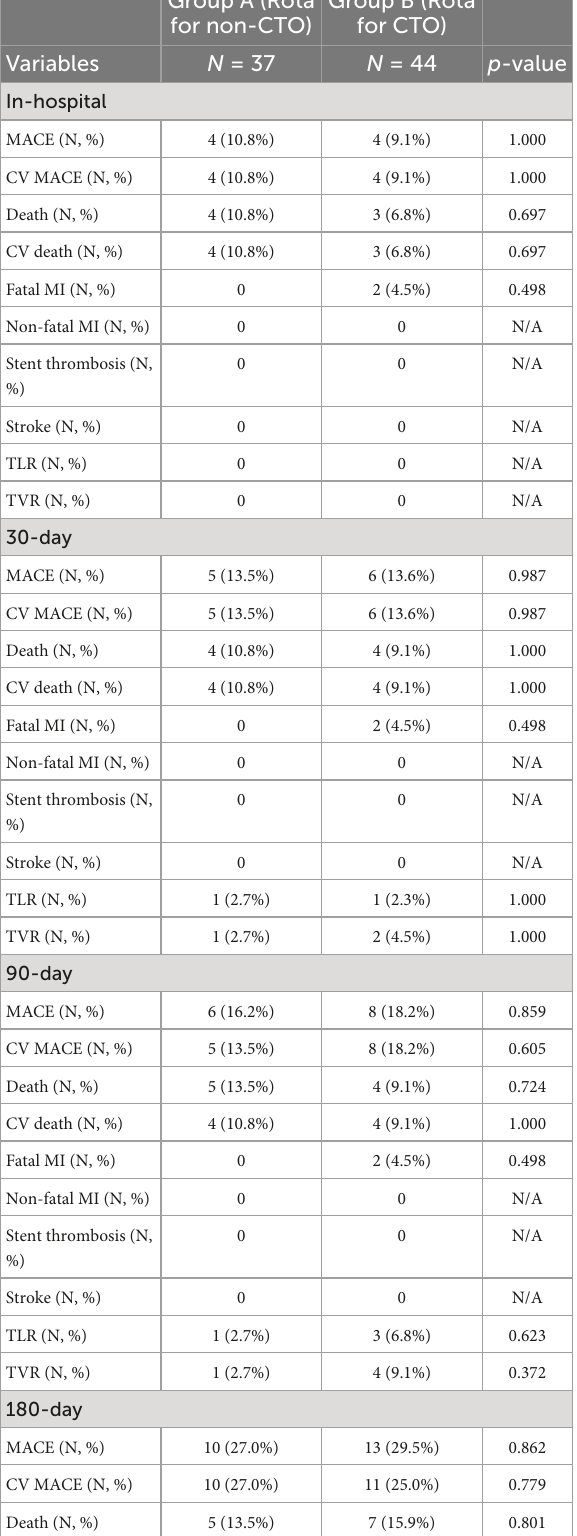
TABLE 4 Clinical outcomes of patients treated with rotablation for CTO and non-CTO lesions. Group A (Rota Group B (Rota for non-CTO) for